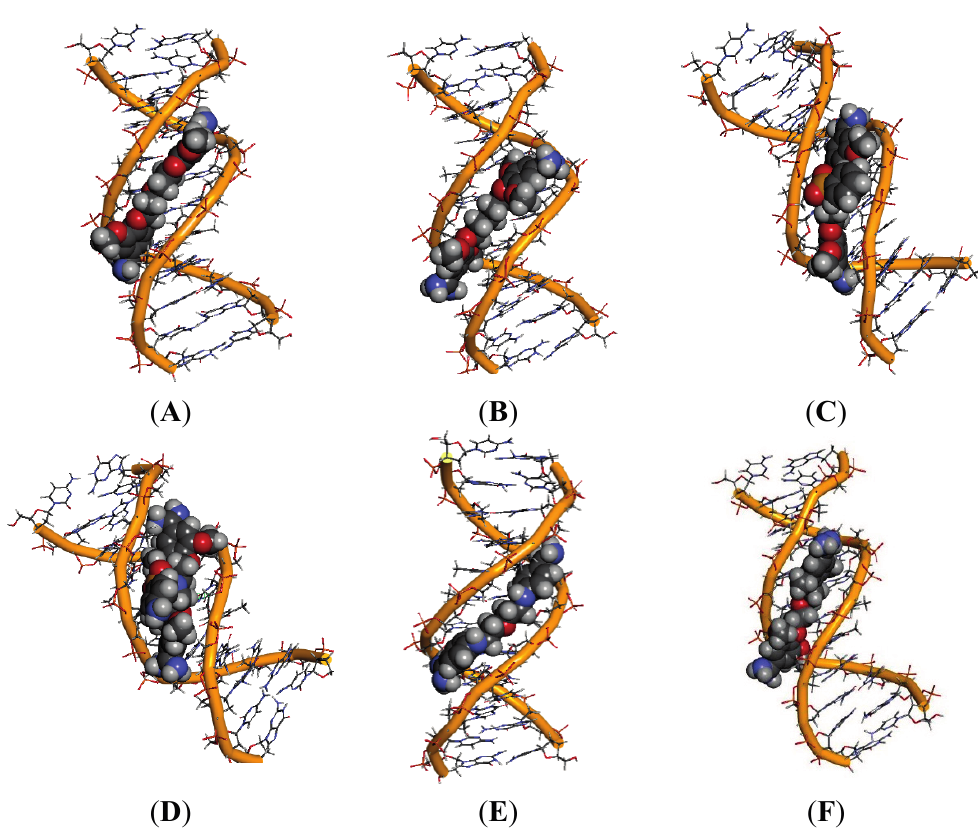
Figure 5. Location of ligands in the minor groove. ( A ) deformation of DNA by 7 ; ( B ) deformation of DNA by 9 ; ( C ) deformation of DNA by 12 ; ( D ) deformation of DNA by 13 ; ( E ) fitted conformation of 5 ; ( F ) deformation of DNA by 8